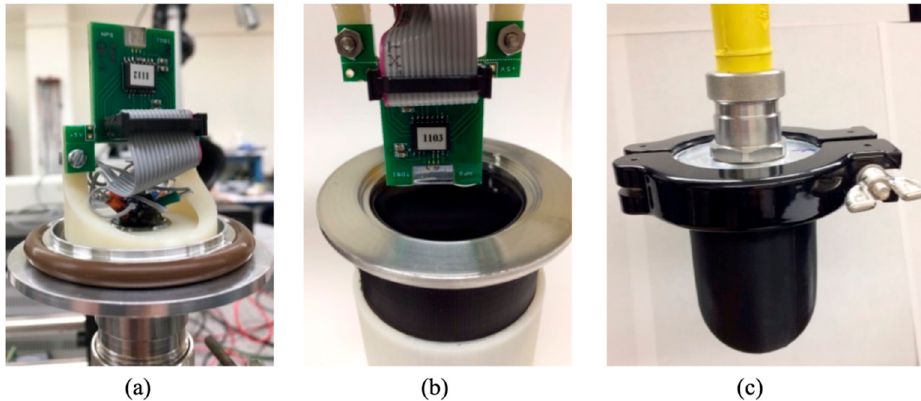
Figure 5. ( a ) Sensor and readout electronics mounted on a flange, ( b ) lowering sensor assembly to a housing containing silicone oil and ( c ) assembled sensor for underwater testing. The boot (black color) was made of PMC-780 polyurethane.